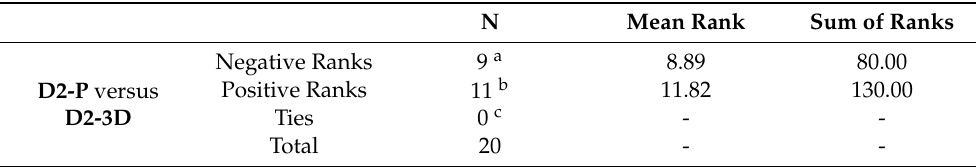
Table 5. Ranks regarding the D2-3D distances compared to the D2-P distances (the Wilcoxon Signed Ranks test